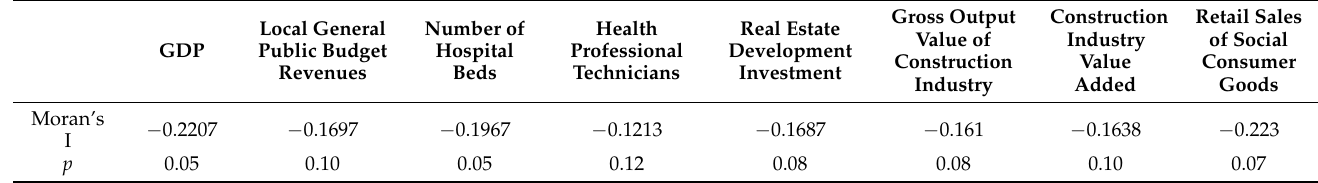
Figure 6. Distribution of new types of expansion patches in each district of Wuhan and calculated GLEI. Table 1. Results of the spatial autocorrelation